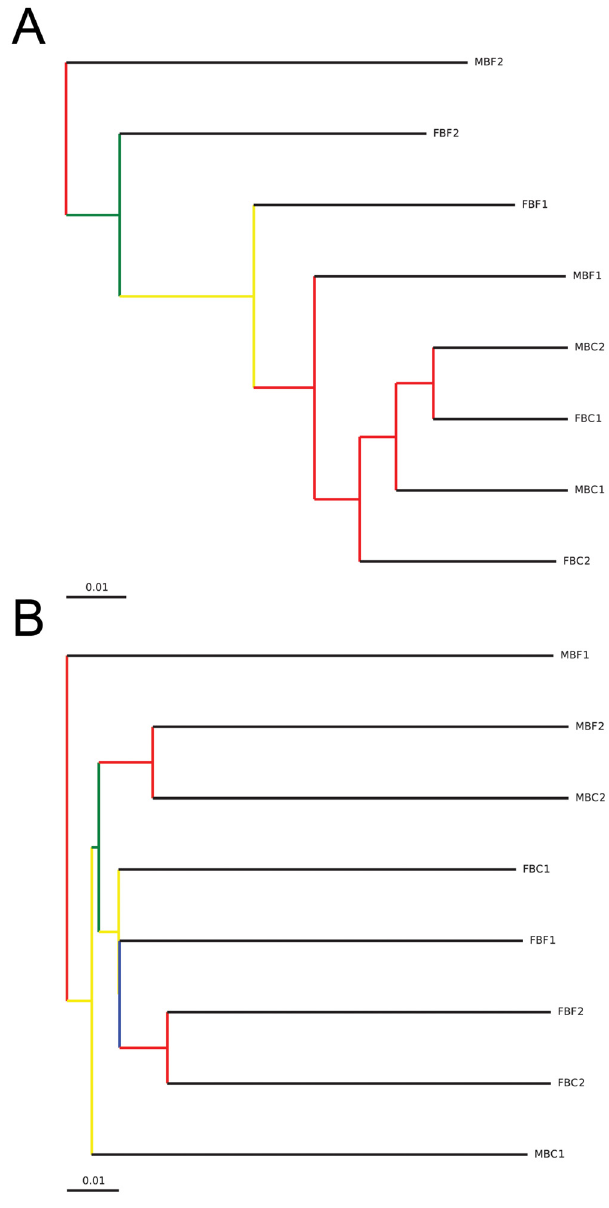
Fig 4. Hierarchical clustering of microbiomes from ceacum and feaces of 4 beavers. Distance matrices were generated with A) weighted and B) unweighted UniFrac calculations. Jack knife analysis was used to evaluate the reliability of the clustering results at even sequencing depth. Nodes colored red show 75 – 100% support, yellow 50 – 75%, green 25 – 50% and blue < 25%